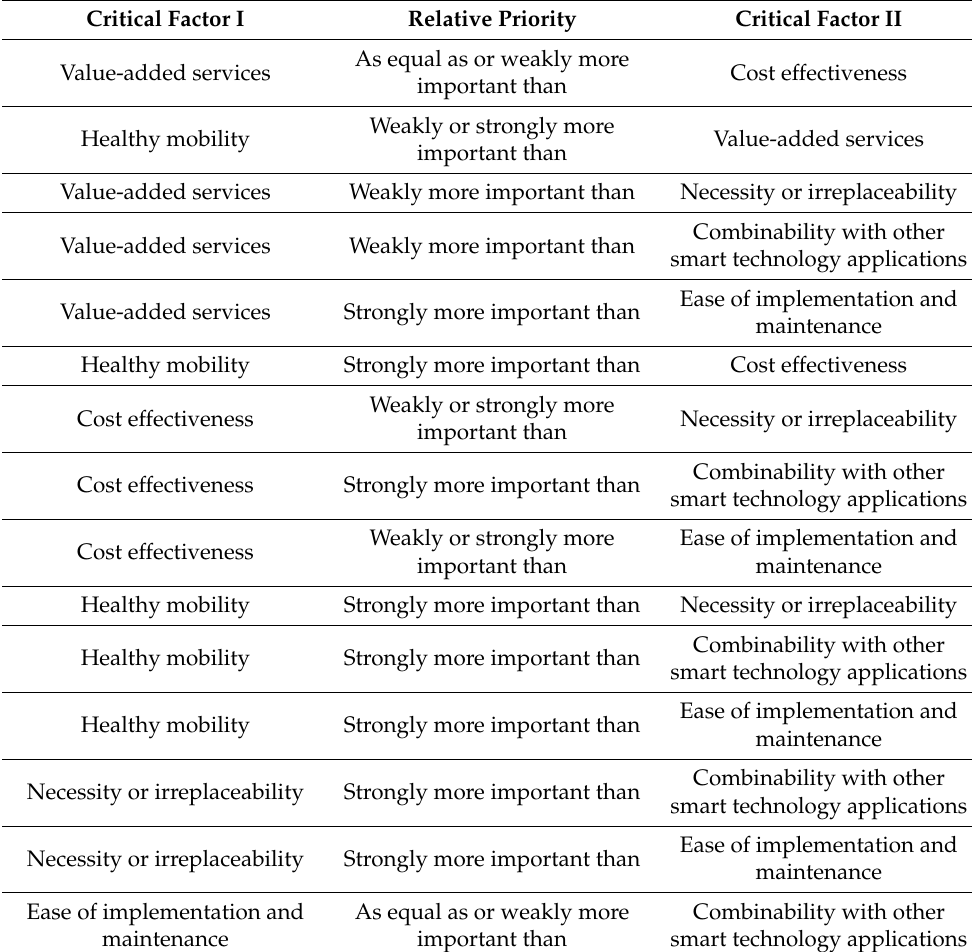
Table 3. Pairwise comparison